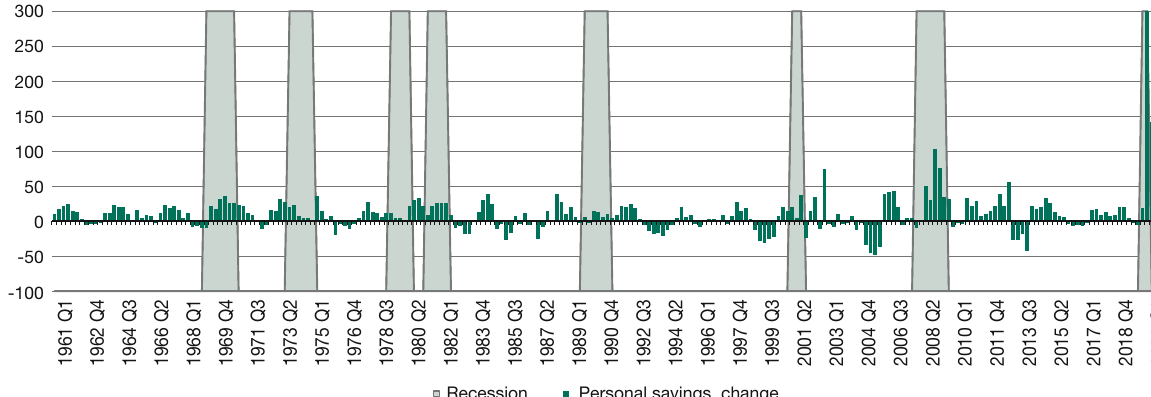
Quarterly personal savings, year-on-year change, US, 1961-2021 Percent change from year ago